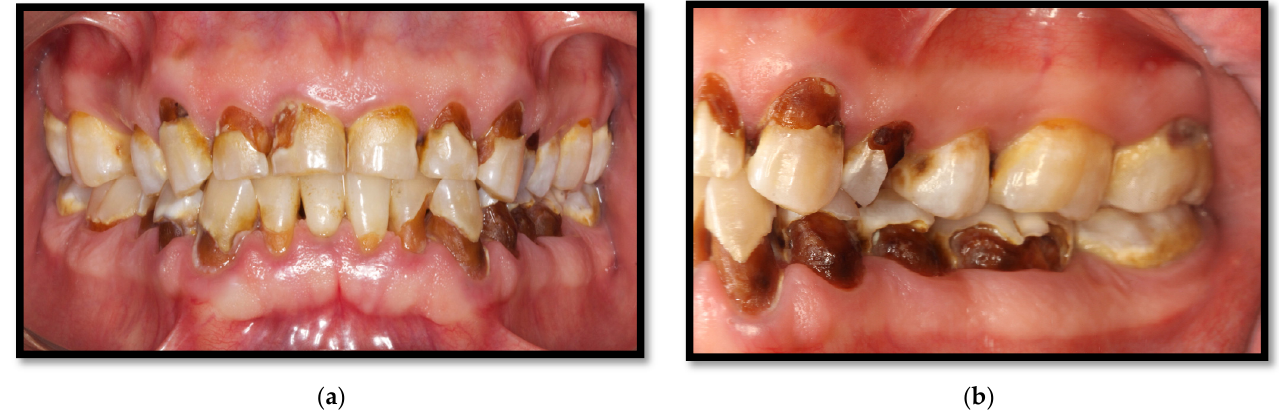
Figure 15. Multiple dental caries. (a) Front view, softened tissue in cervical and interproximal ar- eas; (b) Lateral View, softened tissue in cervical areas ( b ) Lateral View, softened tissue in cervical